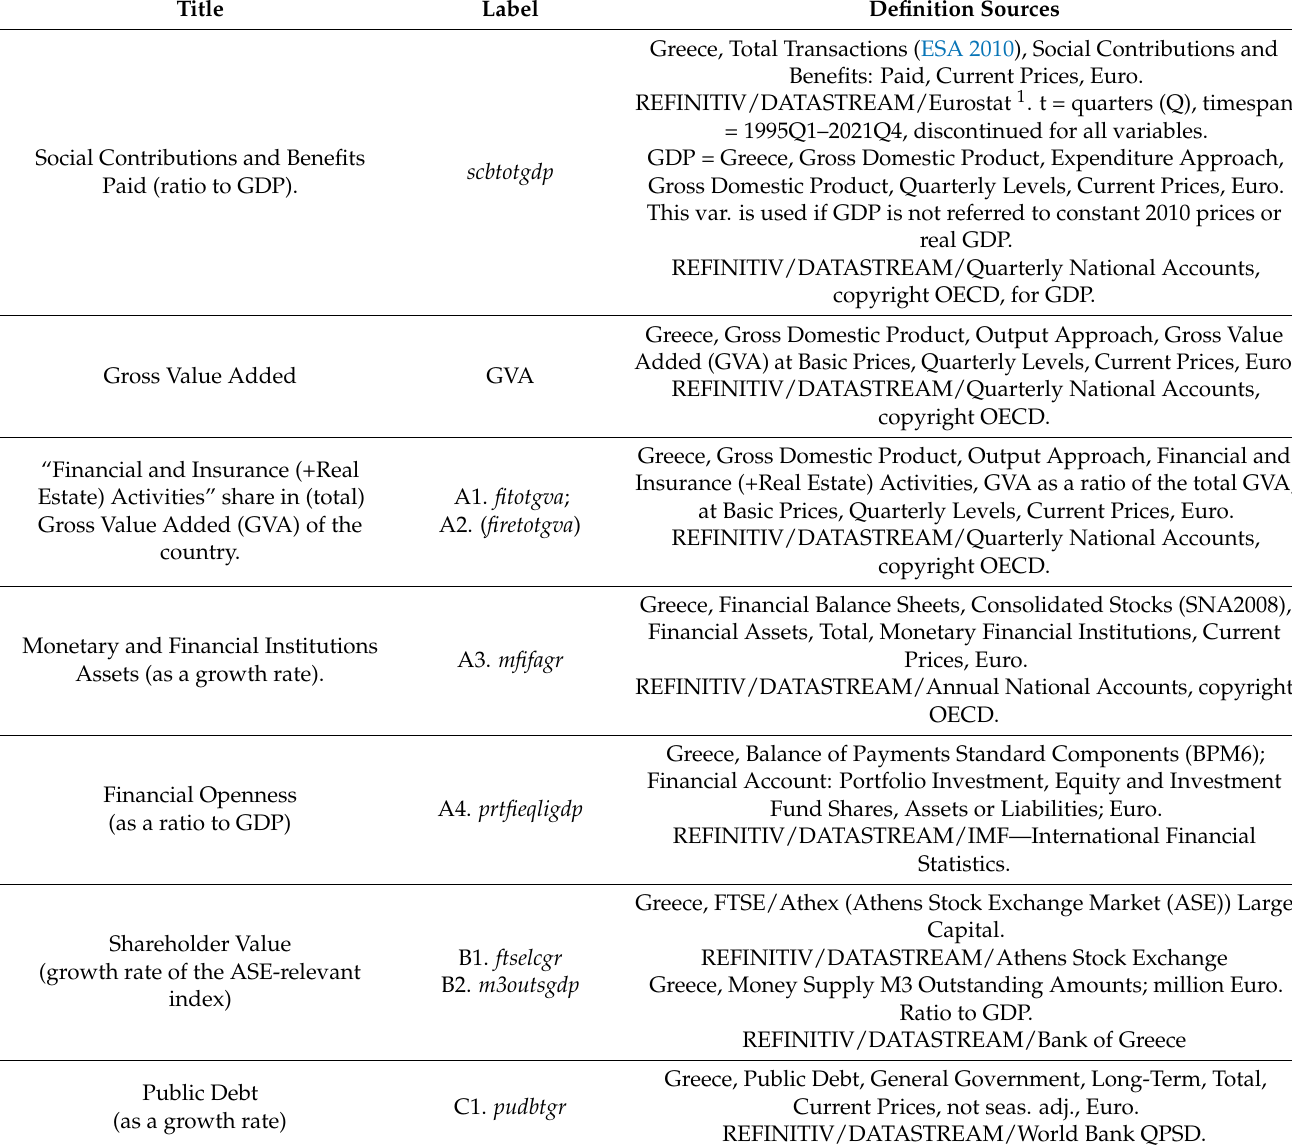
Table A1. Definition and sources of